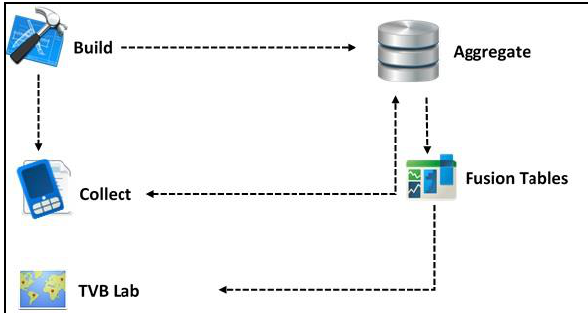
Figure 4. Process diagram of ODK used for